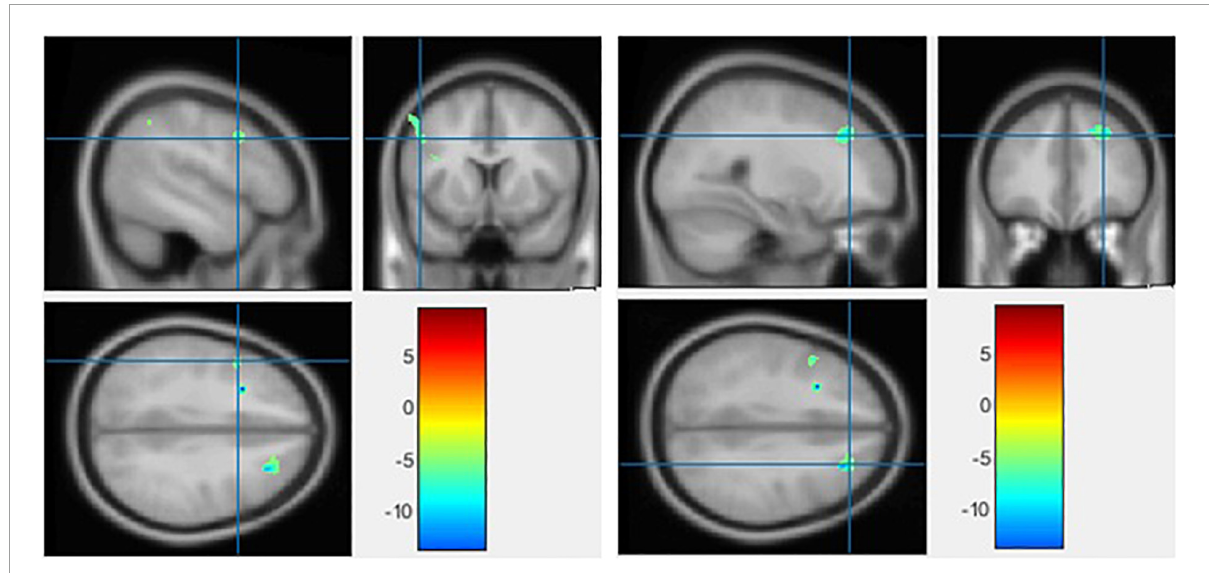
FIGURE6 The significant gray matter (GM) alterations by voxel-based morphometry (VBM) analyses with the covariate of no interest (TIV) in the left precentral gyrus (left) and middle frontal gyrus (right) , respectively, when BD < HC with p < 0.001 (uncorrected) and extent threshold K =